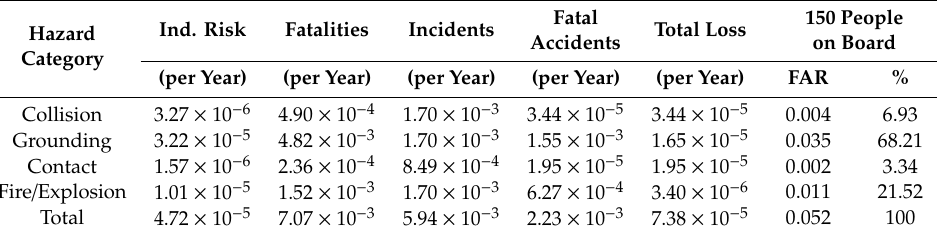
Table 16. Overall risk calculation for ferry.